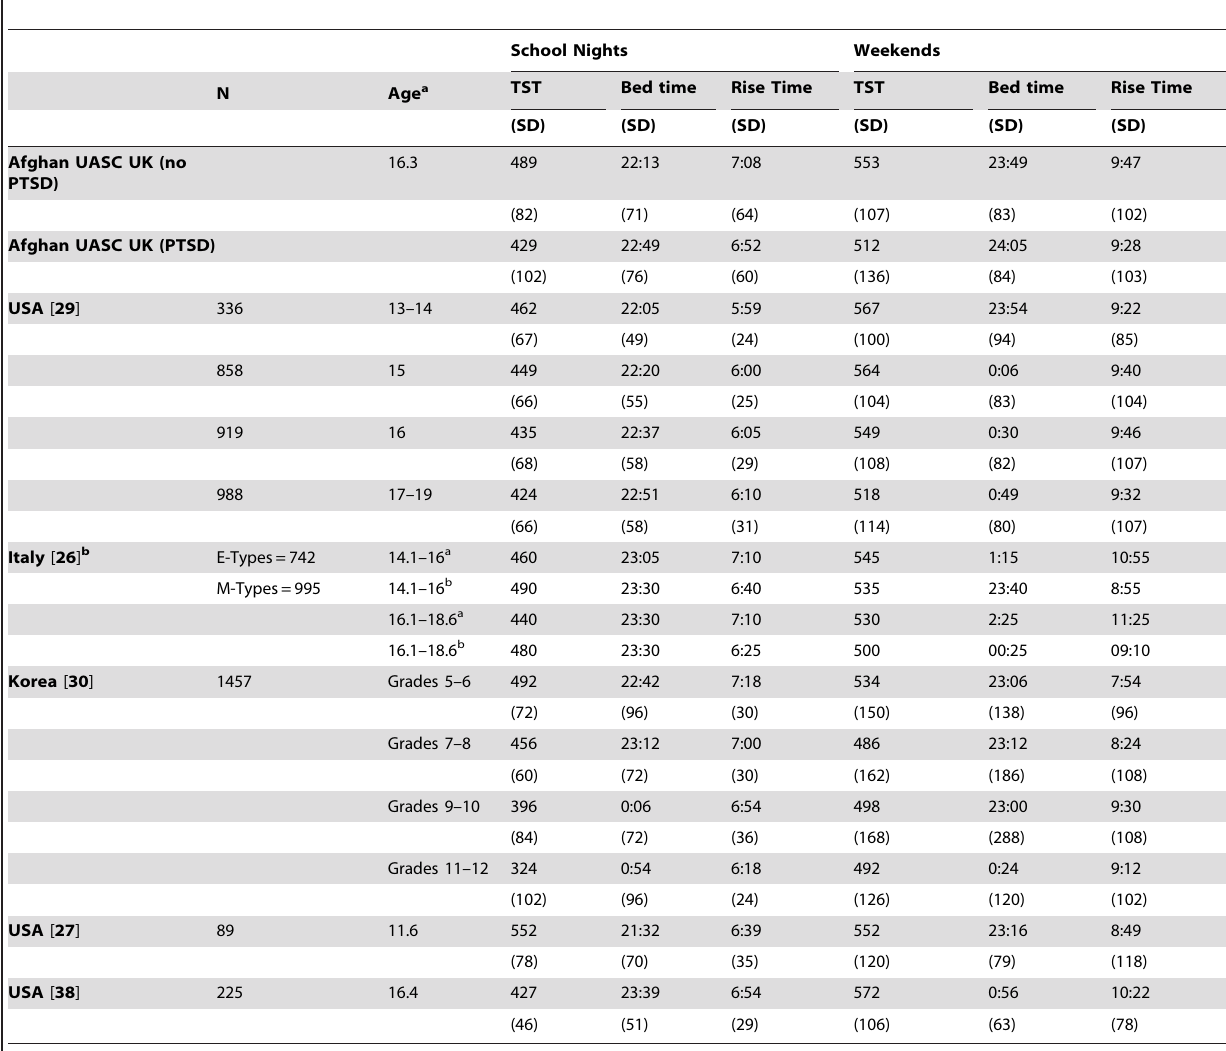
Table 5. Comparison of means for TST, BT, RT, Oversleep, and Bed time Delay from a selection of other studies using the SHS.